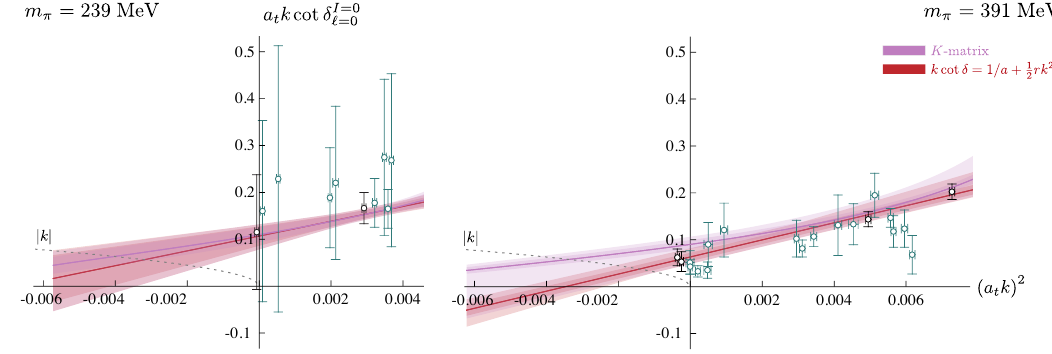
Figure 16 . S -wave scattering amplitudes, plotted as a t k cot δ ‘ =0 , for D ¯ K in I = 0 on the m π = 239 MeV (left) and m π = 391 MeV (right) ensembles. The bands show K -matrix parameter- isation (e) in table 5 and the reference effective range parameterisation, eqs. (5.12) and (5.13), with their statistical uncertainties. Black points are determined from energy levels in the [000] A + assuming ‘ > 4 amplitudes are negligible. Blue-green points are from the non-zero momentum A 1 irreps allowing for the ‘ = 1 amplitude which has been fixed from other irreps. Some points on the left plot with very large uncertainties have been